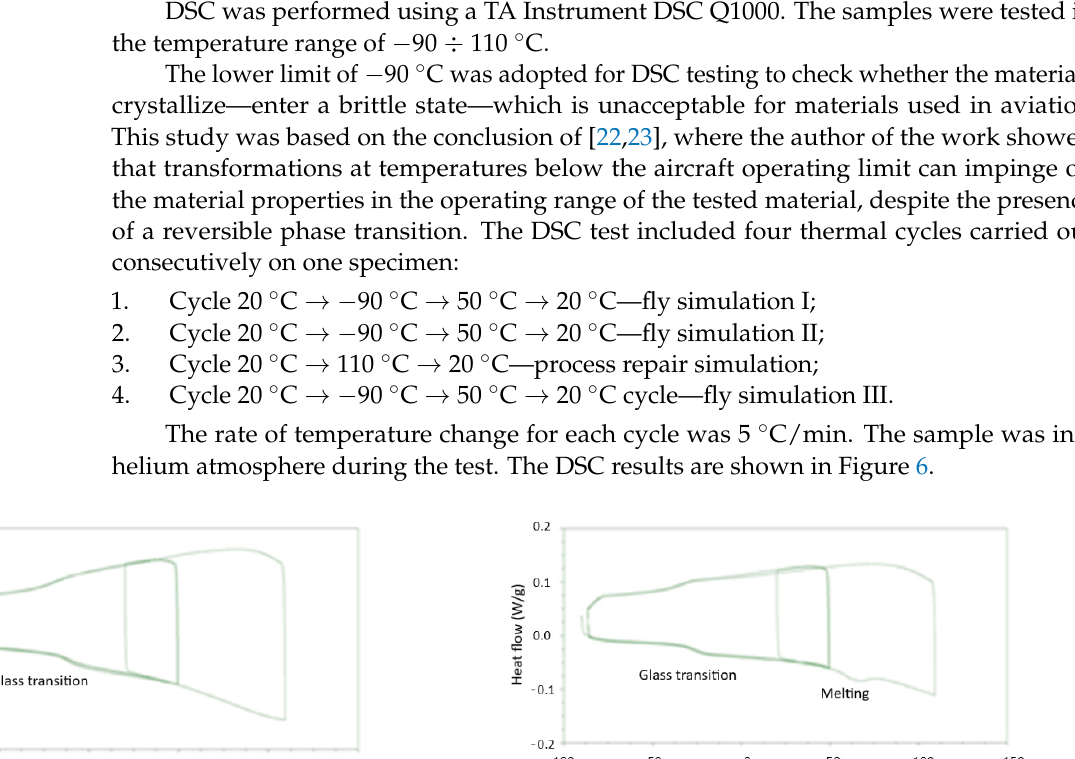
Figure 5. Sampling site and samples for DSC testing: ( a ) Bonding ply; ( b ) Rubber.